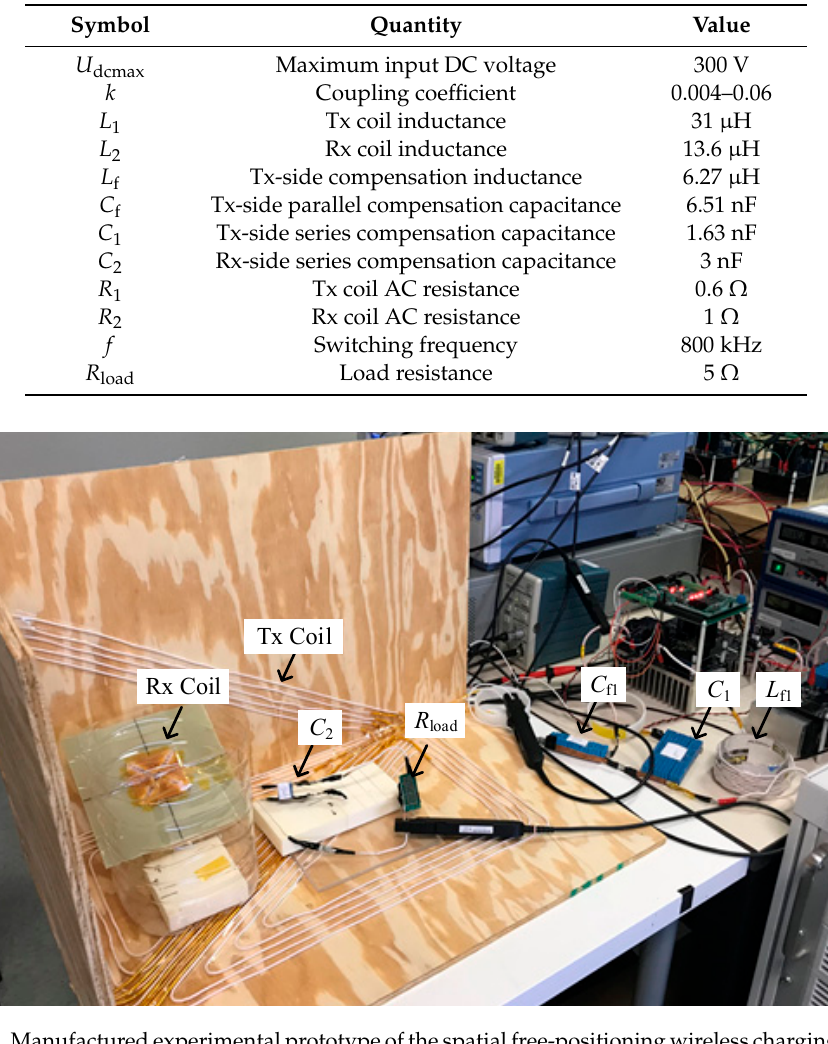
Figure 6. Manufactured experimental prototype of the spatial free-positioning wireless charging system.